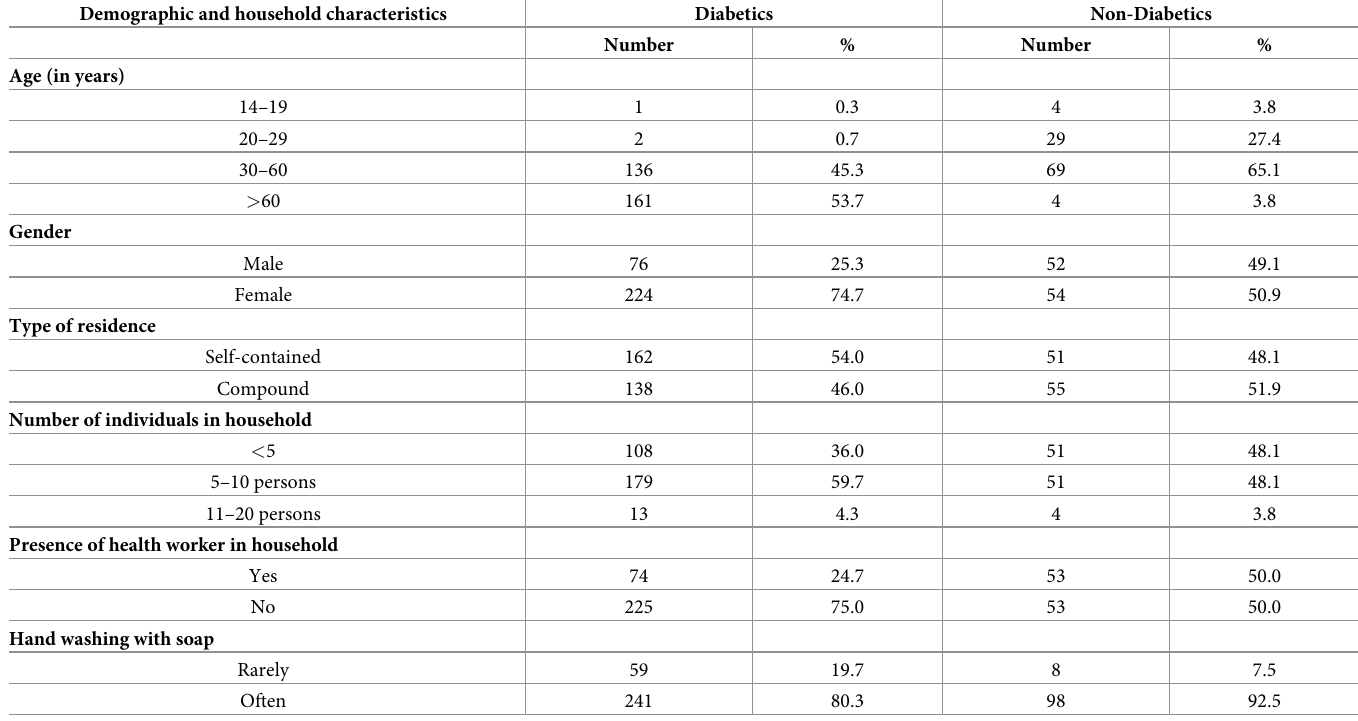
Table 1. Demographic and household characteristics of the study participants. Demographic and household characteristics